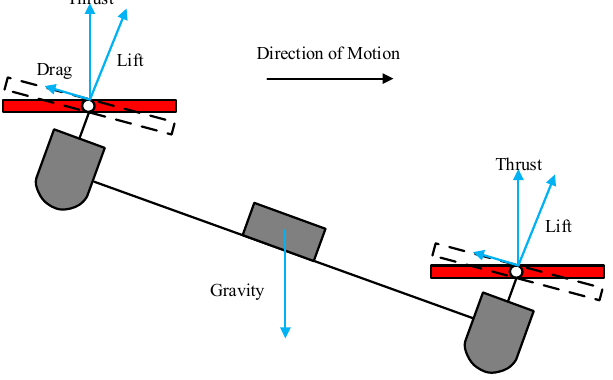
Figure 4. Thrust, lift, and drag forces of propeller during realistic flight.